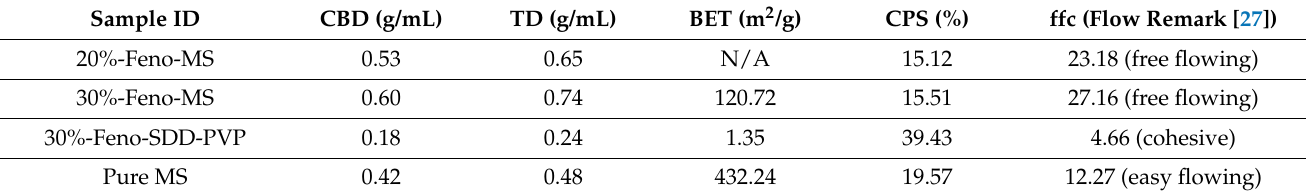
Table 3. Bulk density, tap density, BET, compressibility, and flowability of Feno-loaded MS, Feno- loaded SDD, and mesoporous silica (Parteck ® SLC).